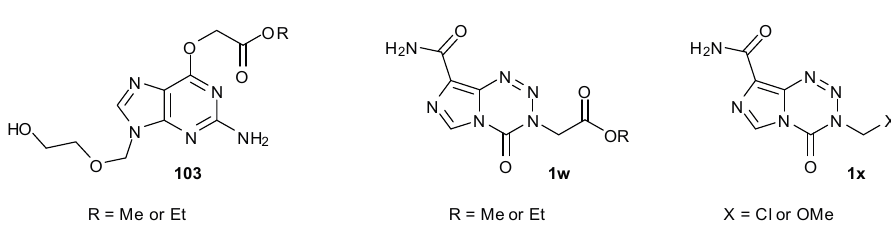
Figure 15. Compounds resistant to MGMT effects